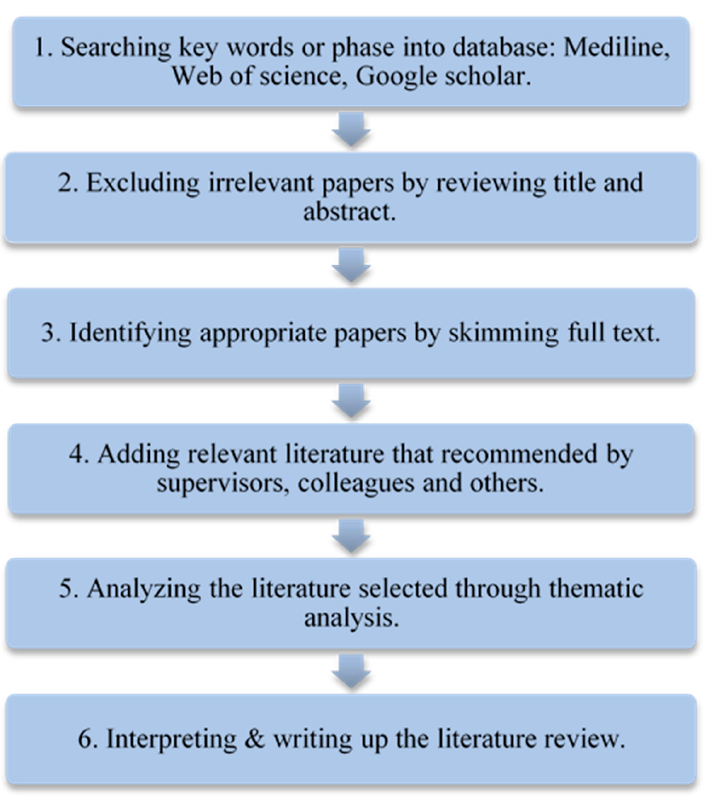
Figure 1. Literature review protocol and process.